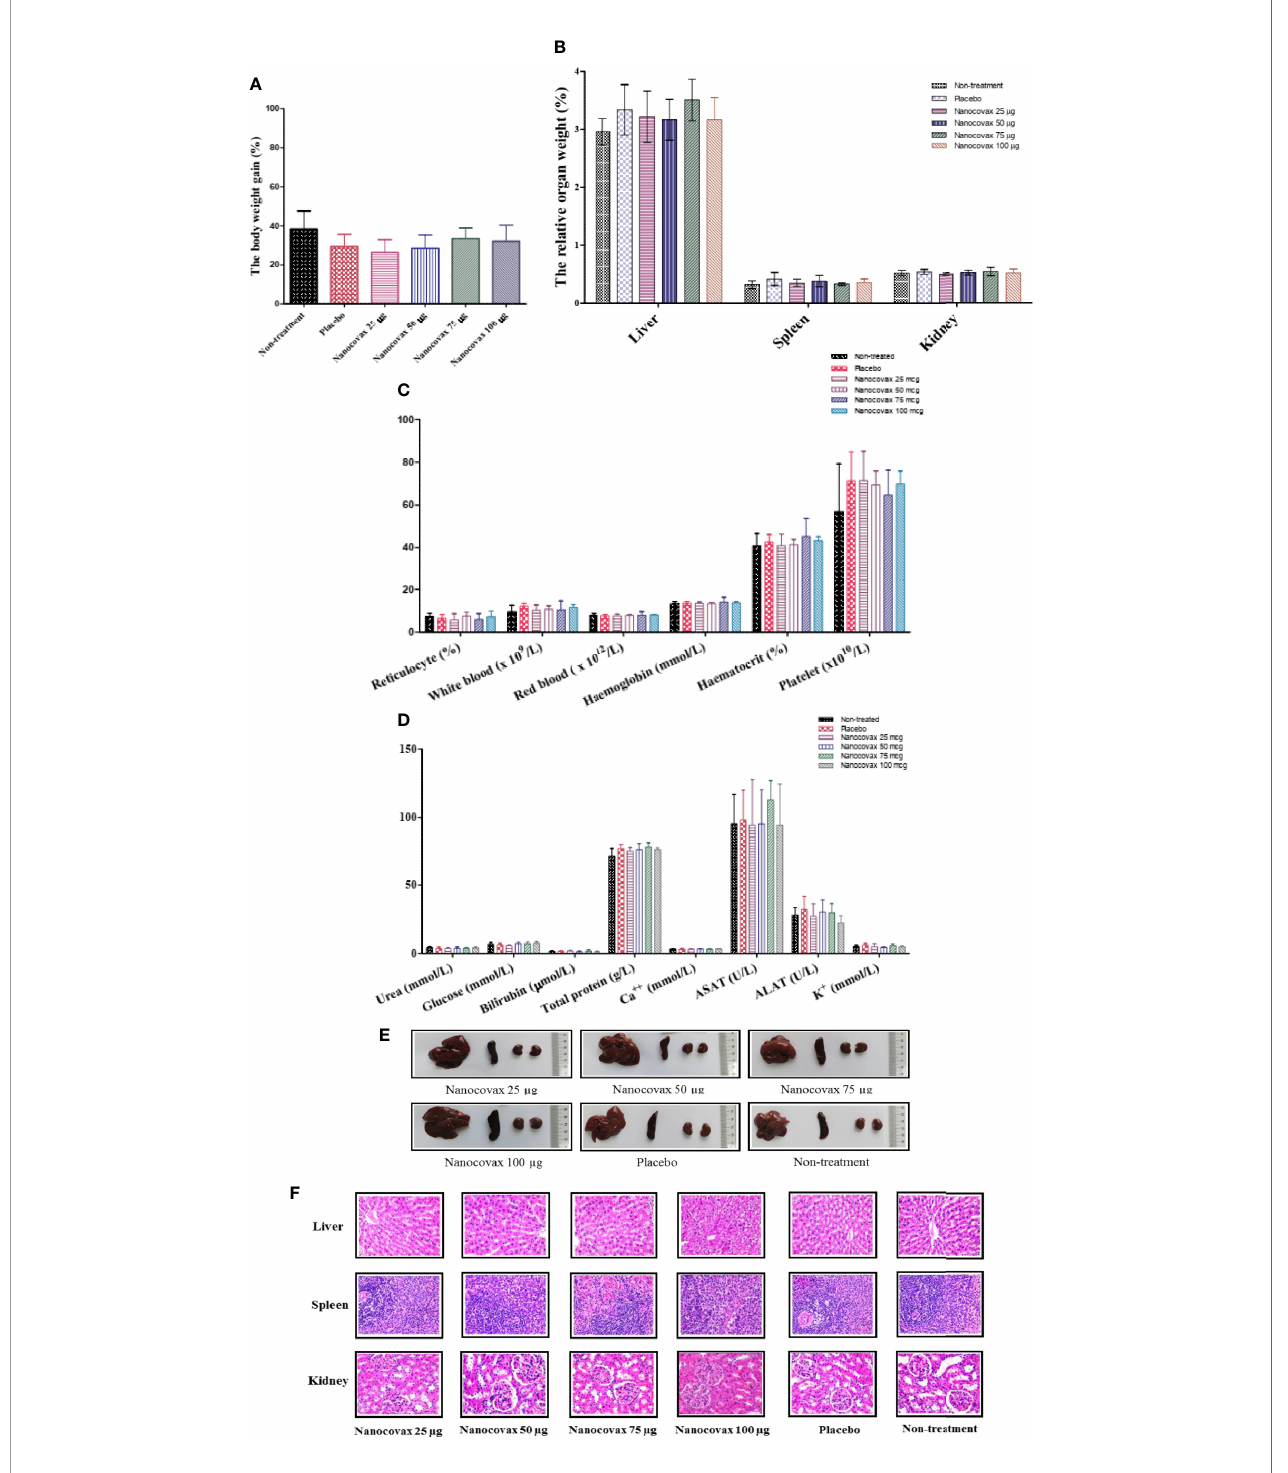
FIGURE 6 | Repeat-dose toxicity study. The repeat-dose toxicity assay was performed on Rattus norvegicus by intramuscular injection once a week for 4 weeks. Pathological signals and weight changes were observed. Body weight gain (A) . Relative organ weights (B) . Indicators of hematological parameters (C) . Biochemical parameters (D) . Anatomical structure of the organs (E) and histological analysis of the liver, spleen, and kidneys (F) in repeat-dose test (magni fi cation ×40). The data represent the mean ± SD, and p -values were determined by two-way ANOVA with Bonferroni post-hoc tests and one-way ANOVA with the Newman – Keuls multiple comparison